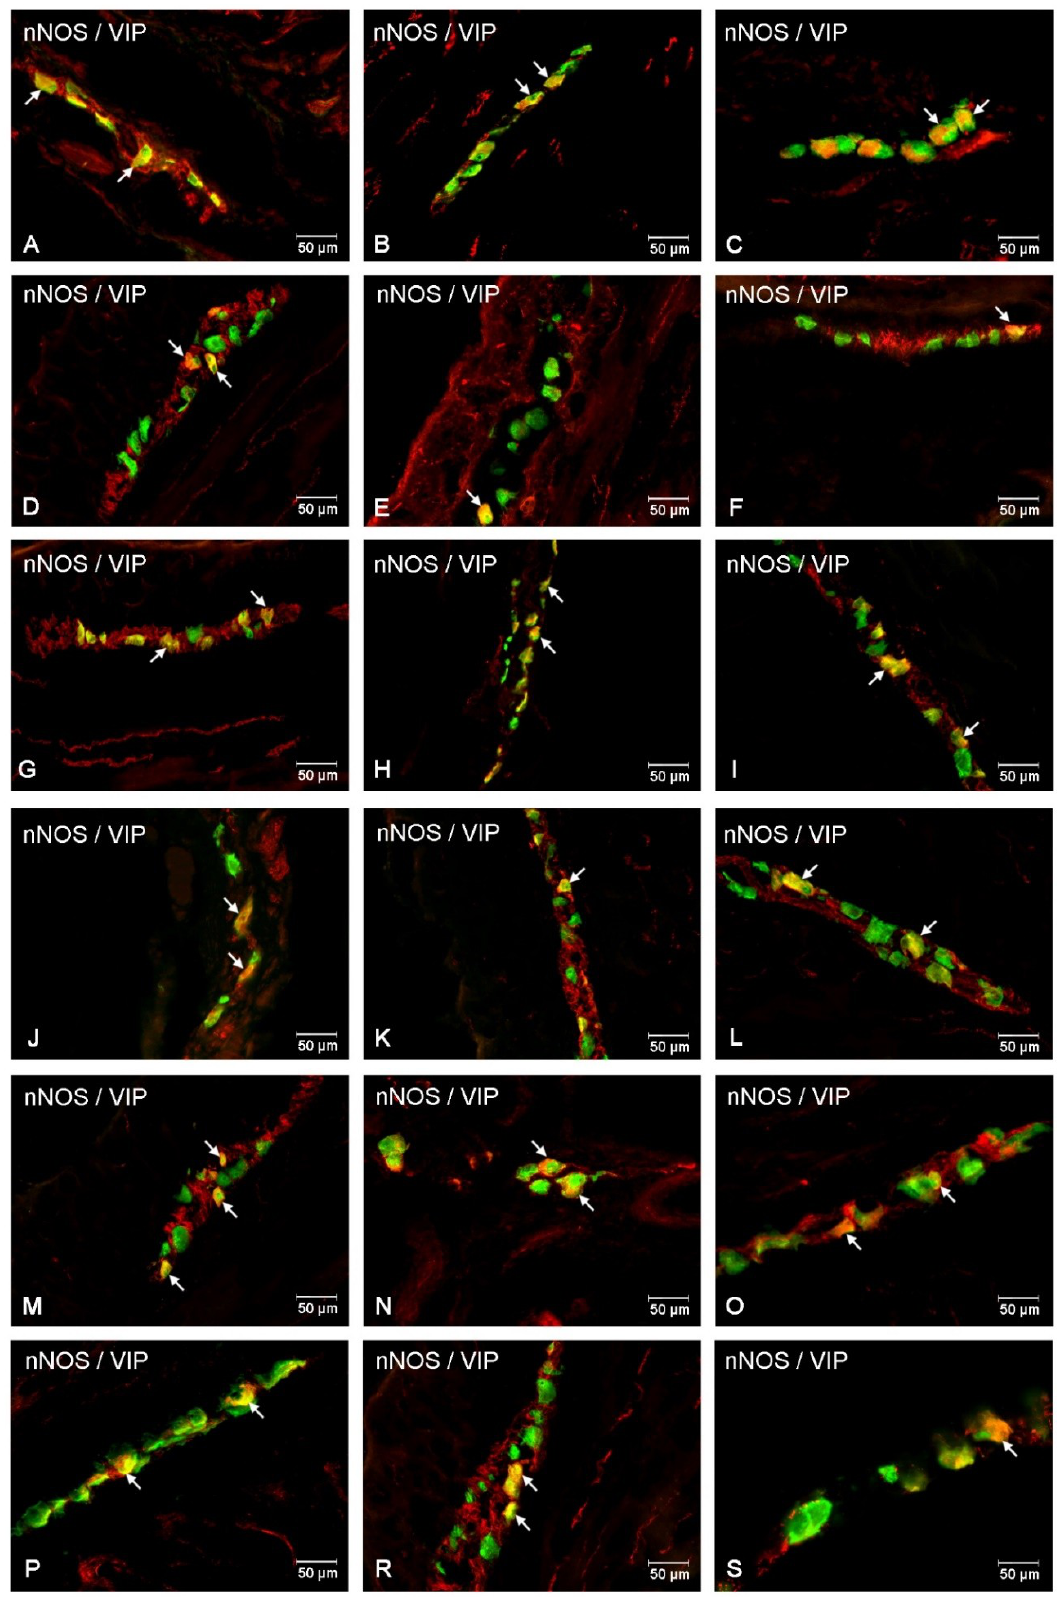
Figure 4. Intramural plexuses in the duodenum, jejunum and ileum immunoreactive to nNOS and VIP. Myenteric plexus in the duodenum ( A , D ), jejunum ( B , E ) and ileum ( C , F ) under physiological conditions (A–C) and after streptozotocin administration (D–F). All photographs were created by digital superimposition of two-colour channels (green for nNOS and red for VIP). Neurons